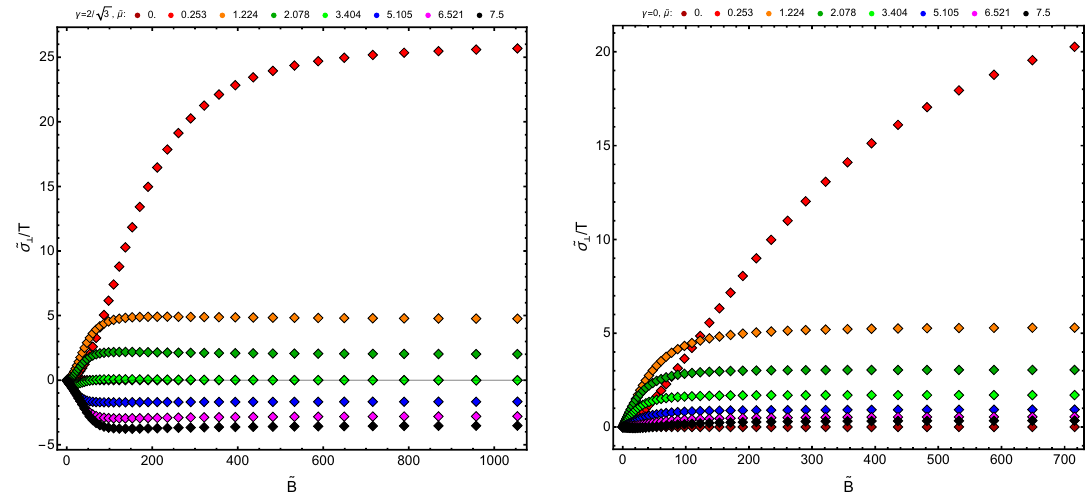
Figure 6 . The dimensionless Hall conductivity ˜ σ ⊥ /T as a function of a large dimensionless magnetic √ field ˜ B . The left panel shows the case γ = 2 / 3 , while the right panel displays γ = 0 .